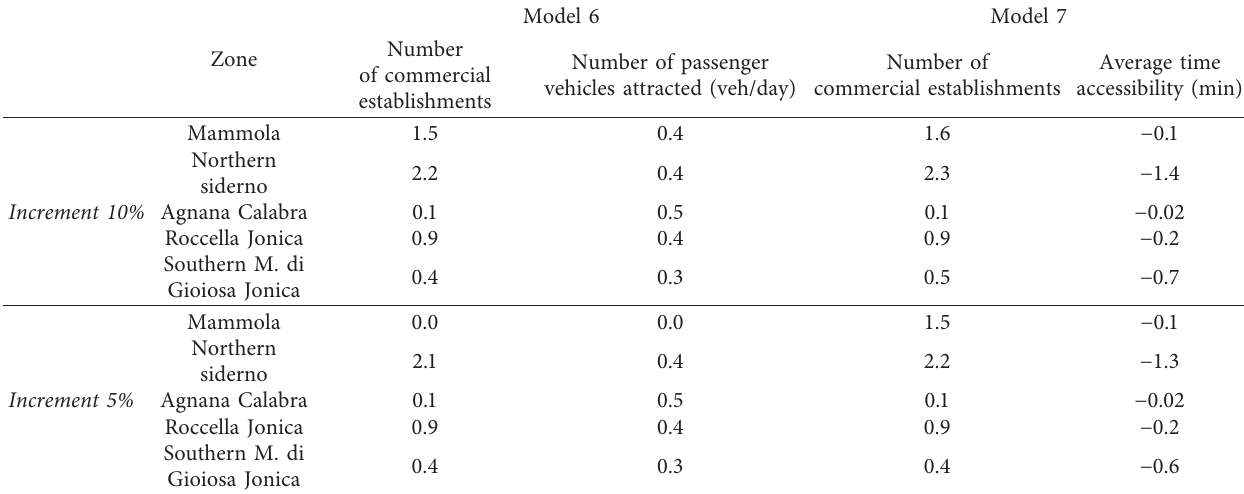
Table 11: Elasticity of models 7 and 8 versus increases of attribute values of +10% and